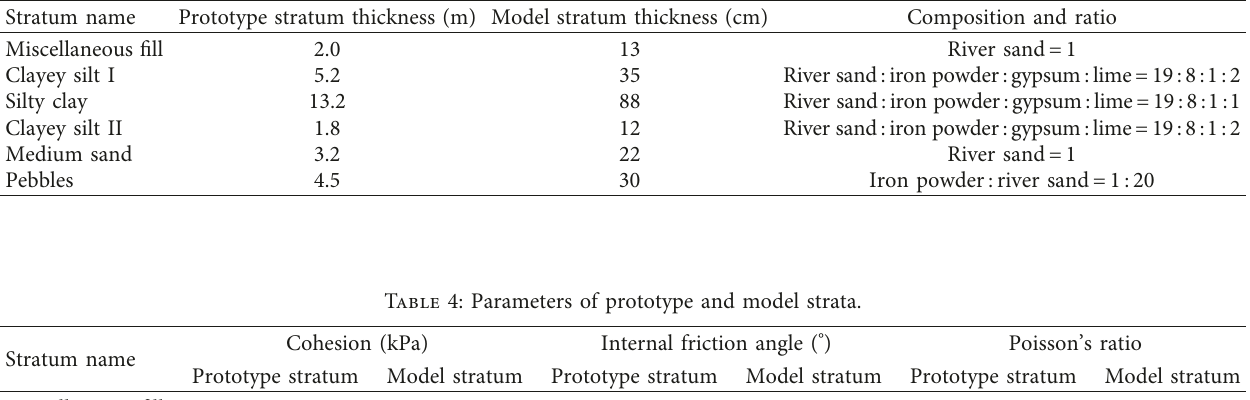
Table 3: Similar material composition and matching ratio of